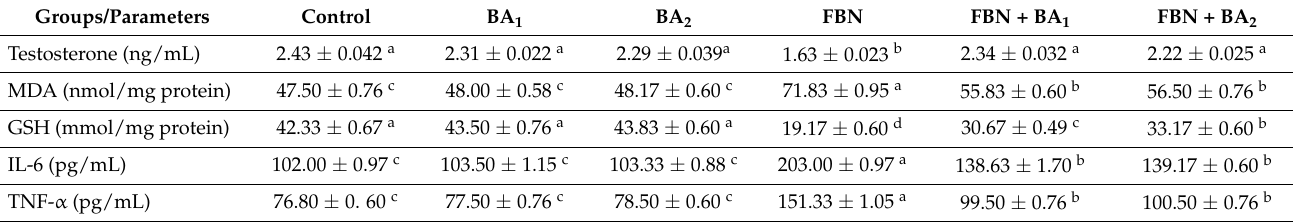
Table 5. The effect of fipronil (FPN) and co-treatment with boswellic acid (BA) on serum testosterone, antioxidant, and pro-inflammatory